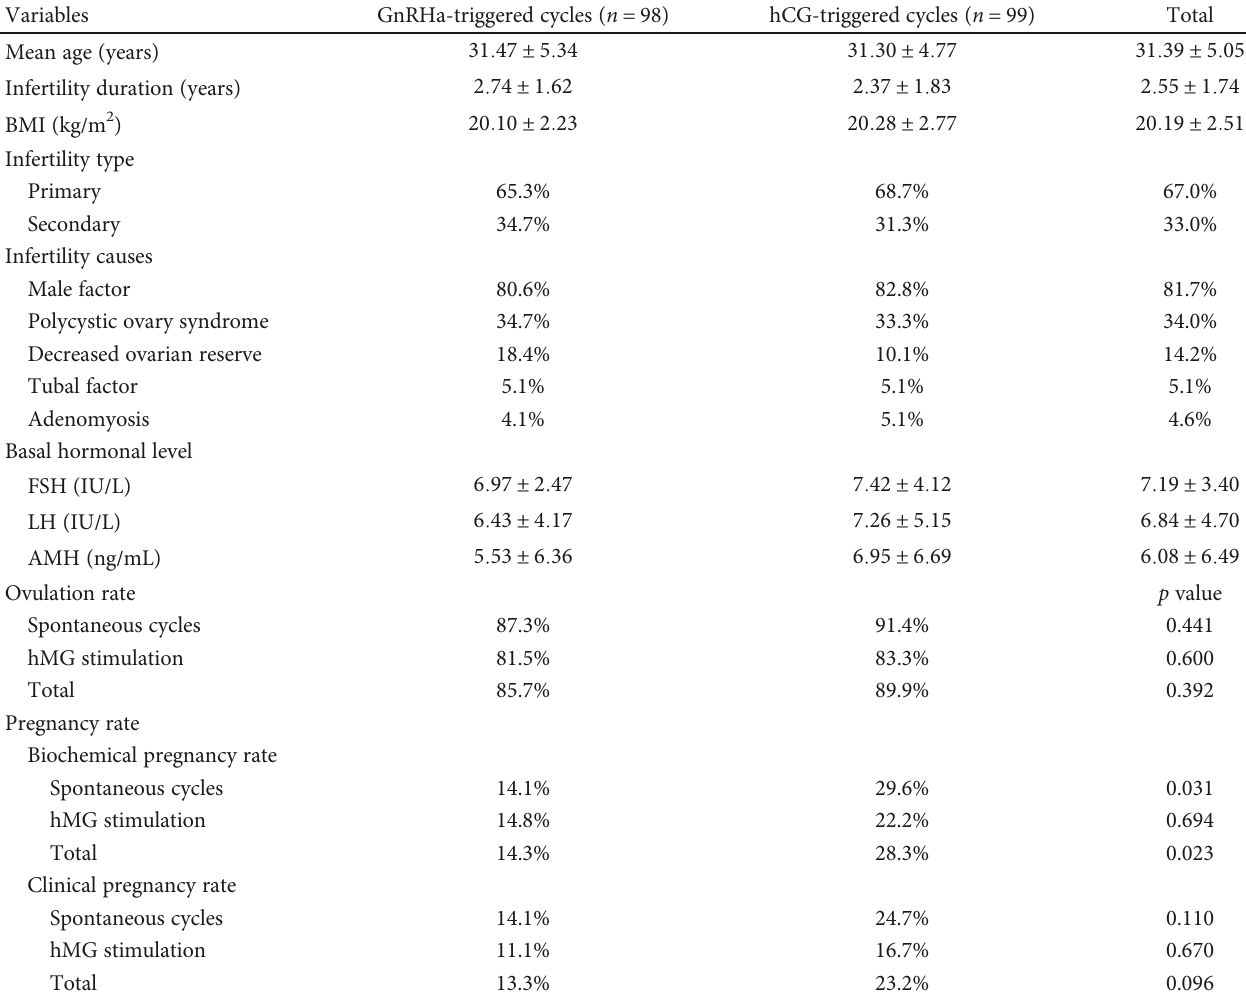
Table 1: Demographic characteristics of the patient population and intervention outcomes between two